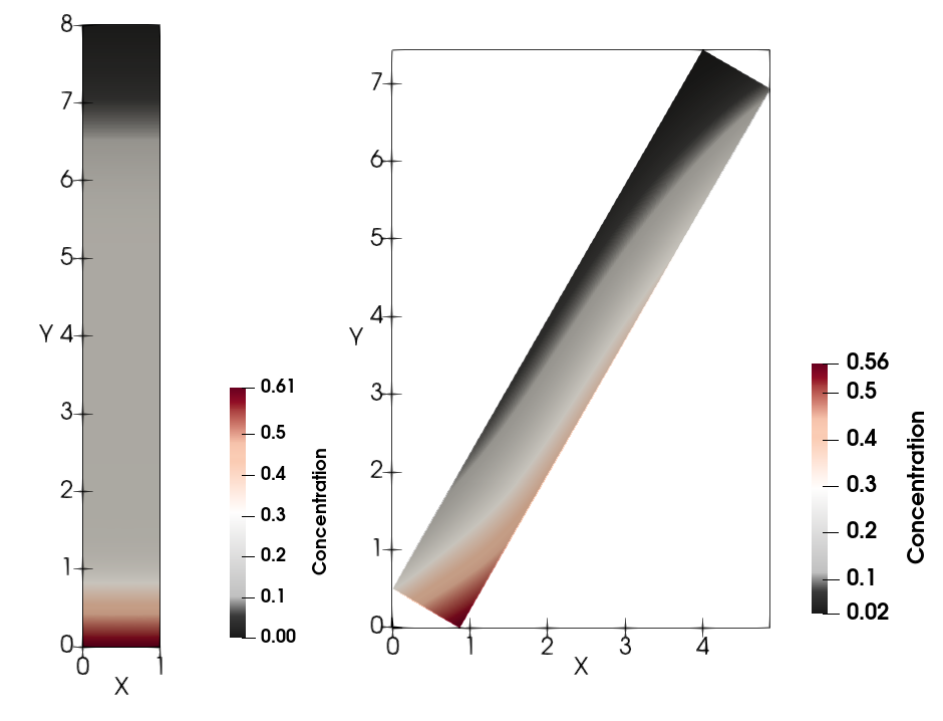
Figure 9. Calculated snapshots of concentration in the case of n = 0.34 for the flux B sh for both the vertical and tilted vessels. The inclination angle is 30 ◦